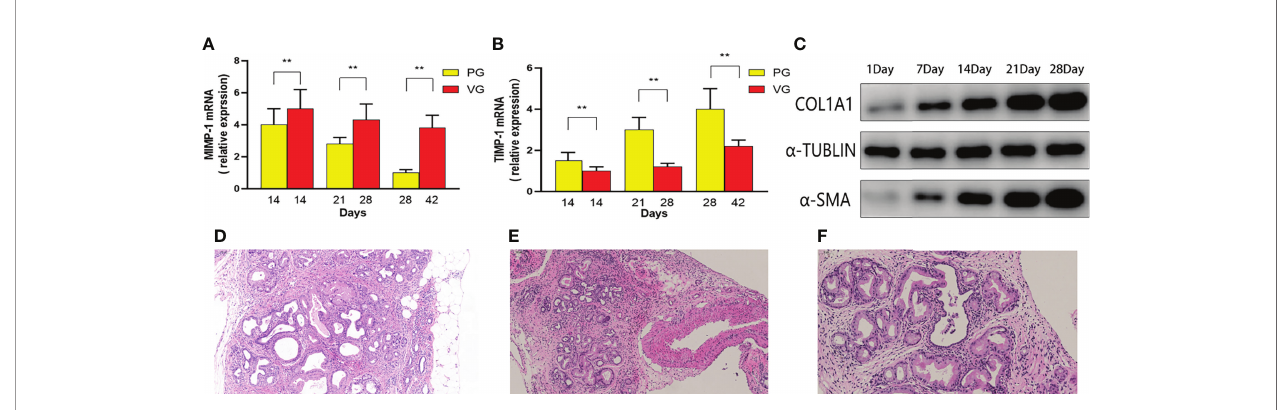
FIGURE 6 | The MMP-1 mRNA and TIMP-1 mRNA contents in mice of PG and VG changed at different time points. (A) Changes in MMP-1 mRNA expression (PG vs. VG). (B) Changes in TIMP-1 mRNA expression (PG vs. VG). (C) The expression levels of a -SMA and COL1 at different time points (PG). (D – F) Representative H&E images of PG 1 month after injection. PG, retrograde pancreatic duct injection group; VG, tail vein